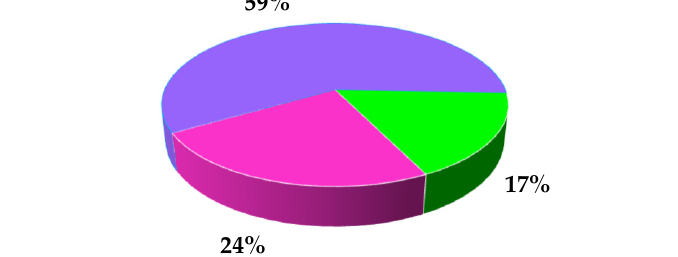
Figure 2. Frequency of described lesions potentially due to Titanium (alloy) and other metal nano- particles released from dental implants and implant-supported restorations, categorized as those likely resembling peri-implant mucositis and peri-implantitis, reactive lesions of the peri-implant mucosa and orofacial, periodontal and peri-implant hypersensitivity